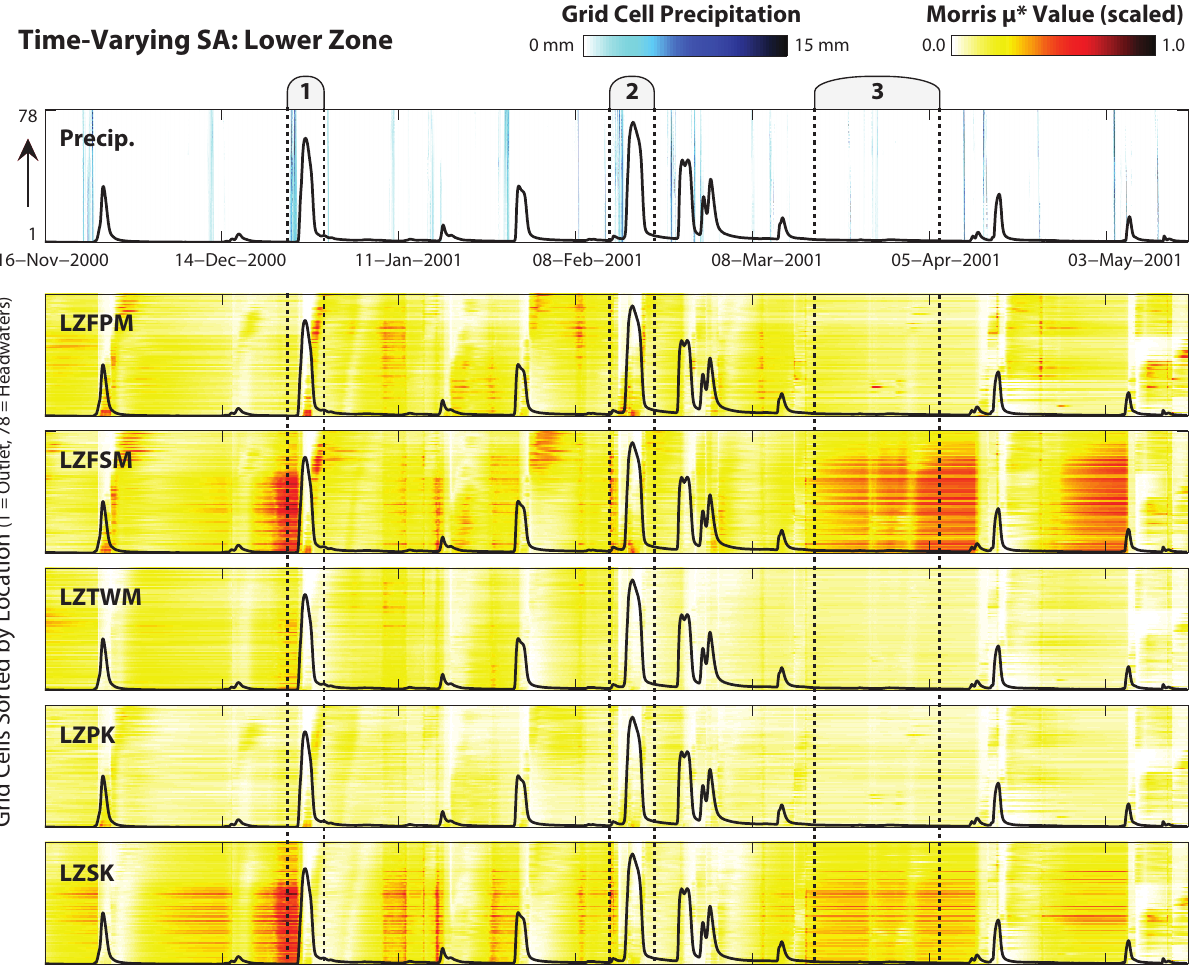
Fig. 6. Time-varying sensitivity of the RMSE metric for the five lower zone parameters of the HL-RDHM model. The indices are calculated for a 24-hour moving window with a 3-hour timestep. The y -axis arranges the 78 grid cells based on their distance from the watershed outlet, from the outlet ( y = 1 ) to the furthest headwater cell ( y = 78 ). The µ ∗ values from the method of Morris are scaled to the range [0 , 1] from an initial range of [0 , 0 . 2] . The lower zone parameters maintain a consistent, moderate level of sensitivity throughout the simulation. Exceptions occur during large events, when the lower zone parameters are mostly insensitive. The secondary storage parameters, LZFSM and LZSK , are particularly sensitive during low-flow periods.